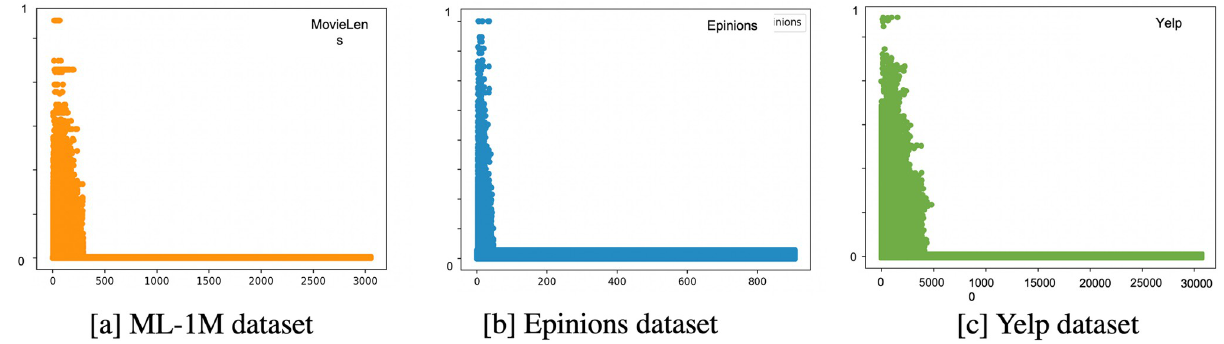
Fig 8. Similarity values between the neighbors and the target user of three datasets. [a] ML-1M dataset. [b] Epinions dataset. [c] Yelp dataset.